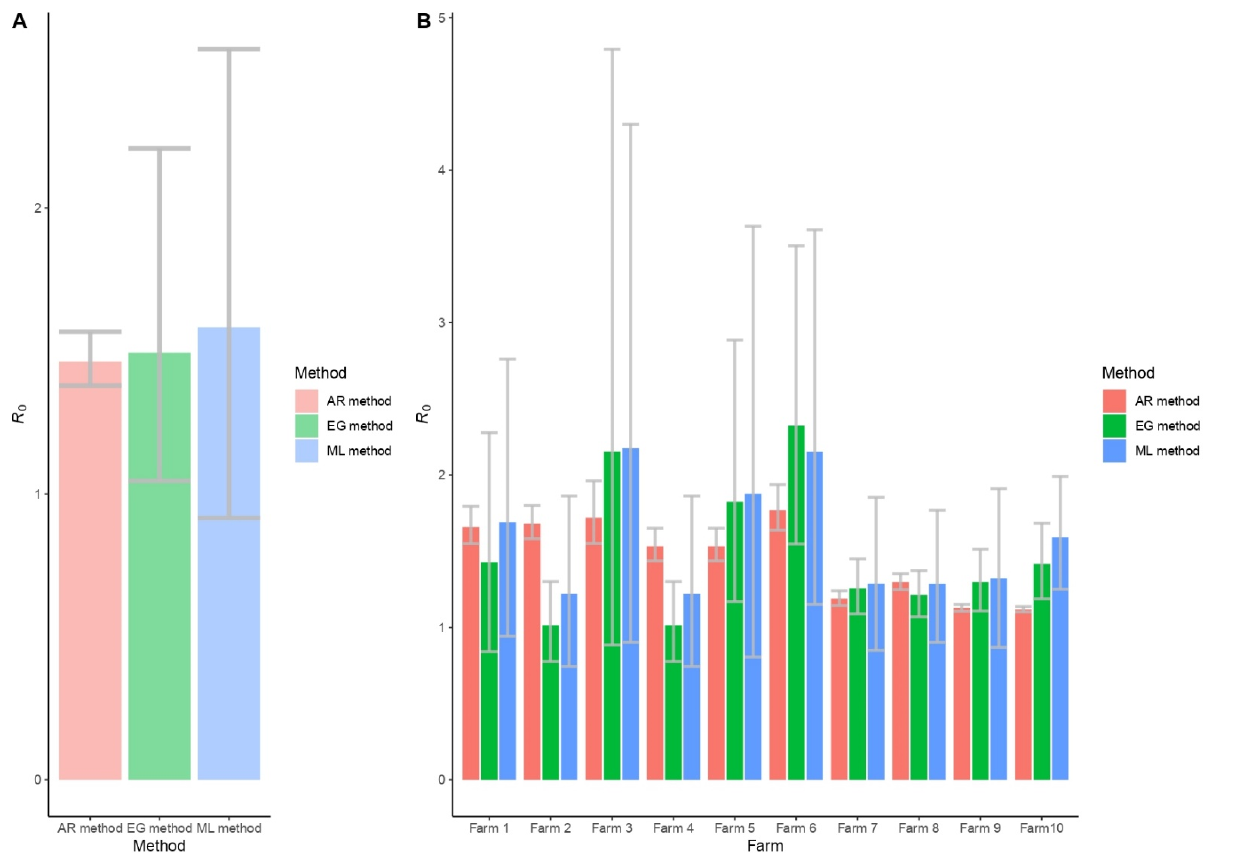
Figure 1. The R 0 values of within-farm ASF transmission are estimated with the exponential growth method (EG), maximum likelihood method (ML), and attack rate method (AR). ( A ) Overall R 0 values summarized from all recruited farms. ( B ) R 0 values of each farm.